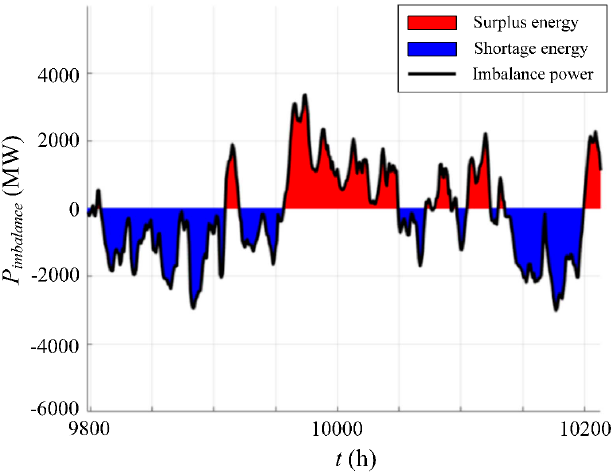
Figure 10. The imbalance power profile with surplus and shortage energy.